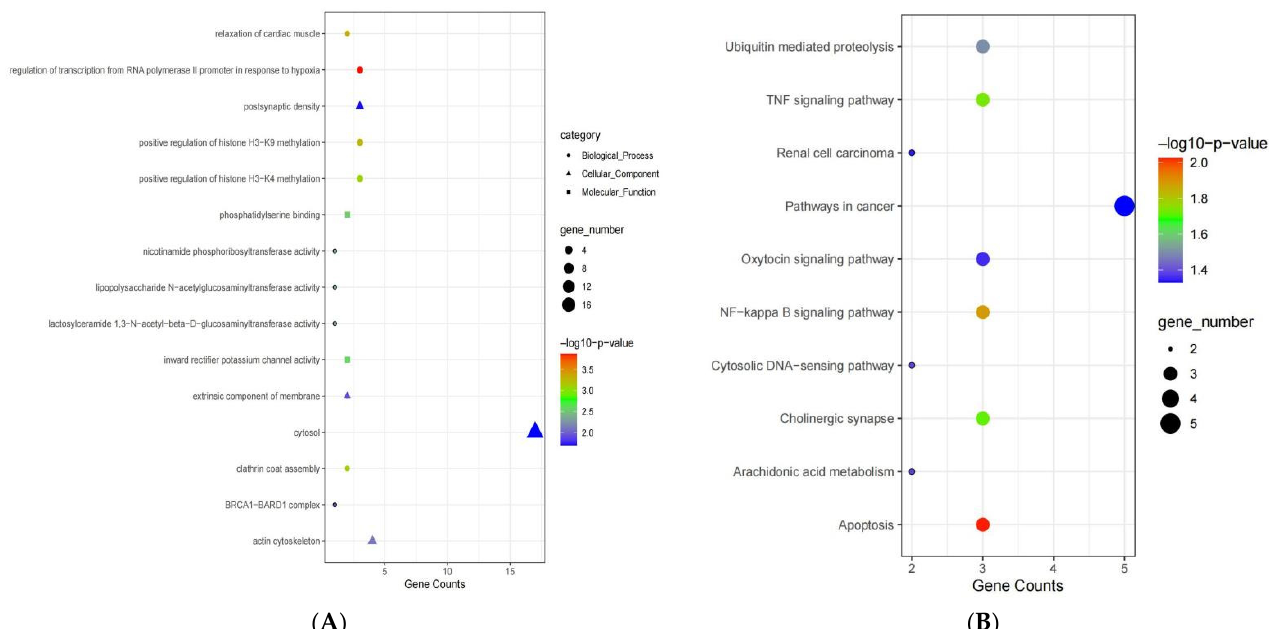
Figure 3. ( A ) GO enrichment analysis of genes in the blue module. ( B ) KEGG pathway analysis of genes in the blue module.